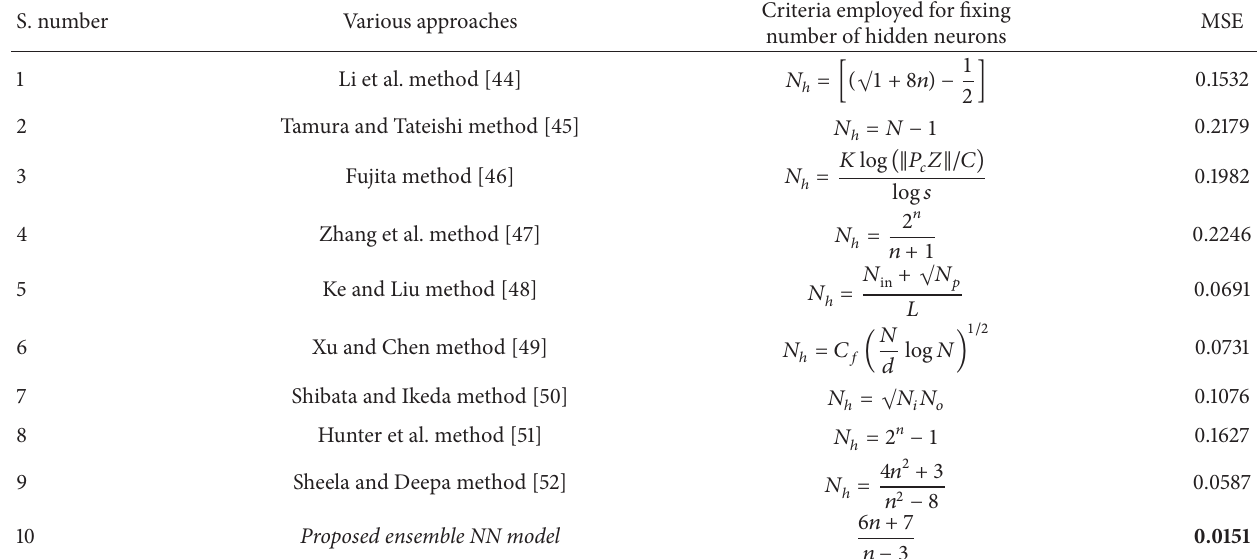
Table 7: Comparison of MSE for the approaches in the existing and proposed ensemble NN model. S. number